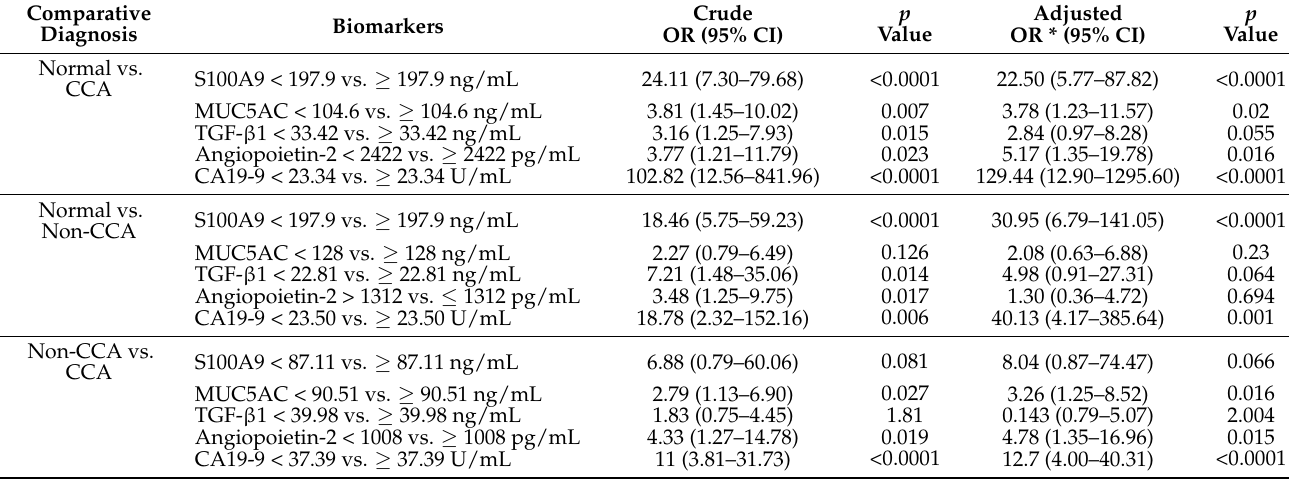
Table 4. The predictive risk of CCA and other cancers relative to normal control group by using serum levels of candidate biomarkers